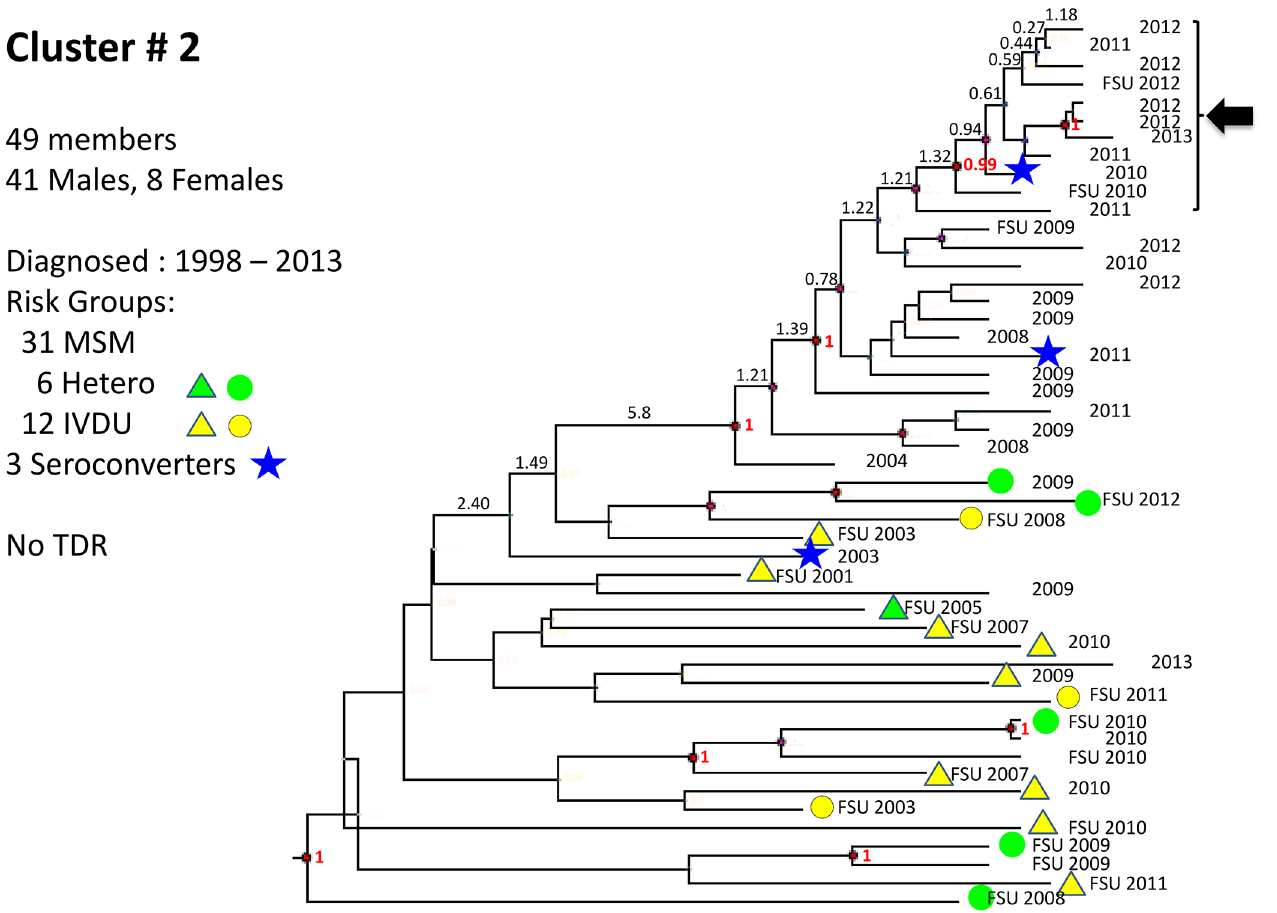
Fig 7. Cluster # 2. Cluster 2 is composed of 41 males and 8 females, diagnosed between 1998 and 2013 and genotyped between 2007 and 2013. The group contains 3 seroconverters who were diagnosed 7 years apart (in 2003, 2010 and 2011). A transmission network of 10 members is noted (arrow). Notations as in Fig